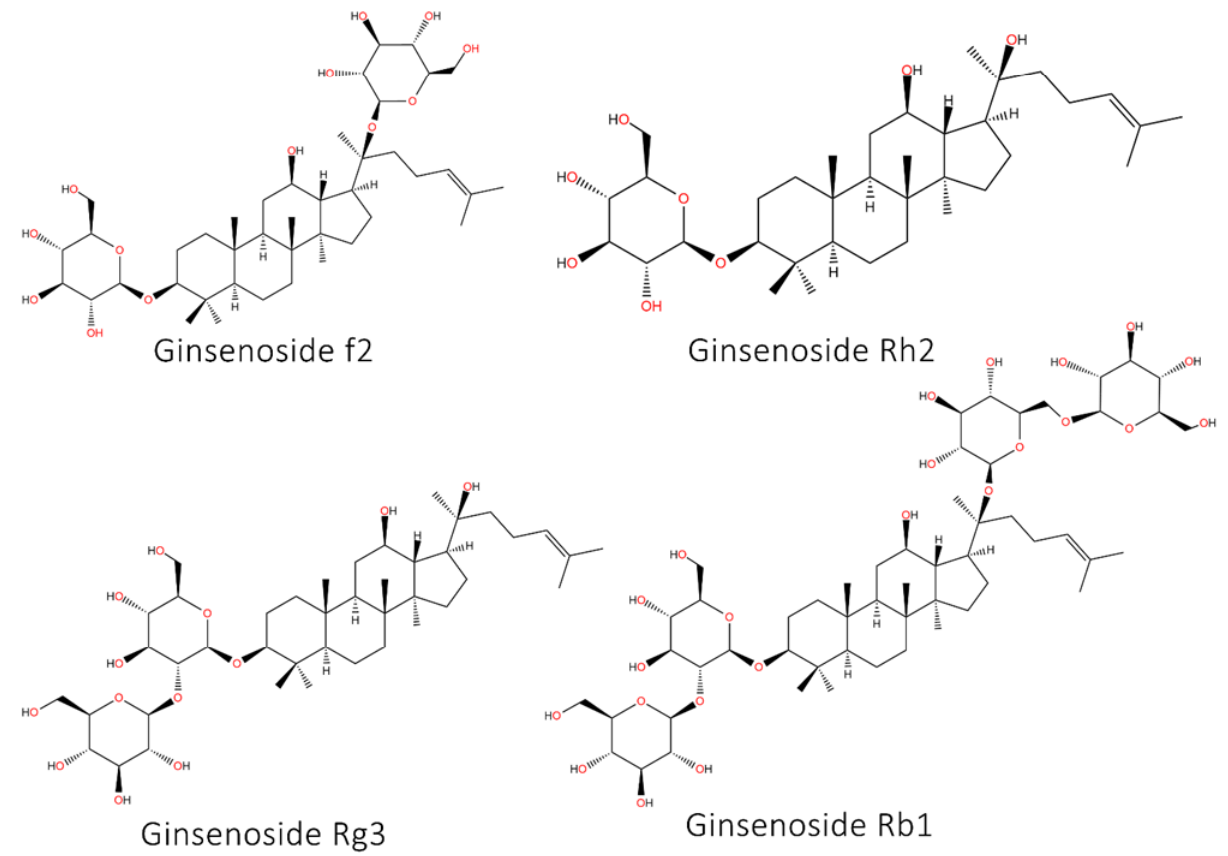
Figure 9. Chemical structures of ginsenosides. Table 9. Ginsenosides as potential inhibitors of CSCs in different tumors.